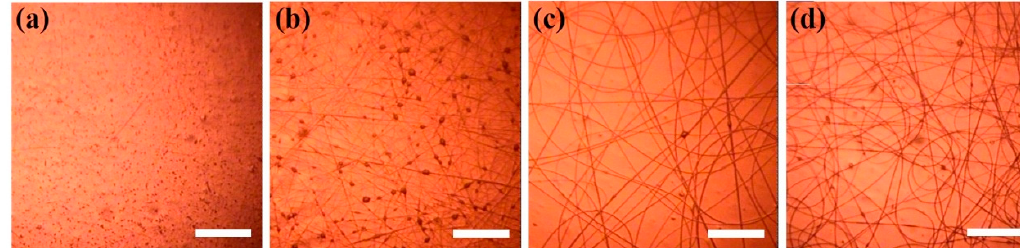
Figure 2. Optical micrographs of PAN nanofiber films electrospun with PAN mass fraction of ( a ) 8 wt%; ( b ) 10 wt%; ( c ) 12 wt% and ( d ) 15 wt%, respectively. The scale bar is 100 µm.